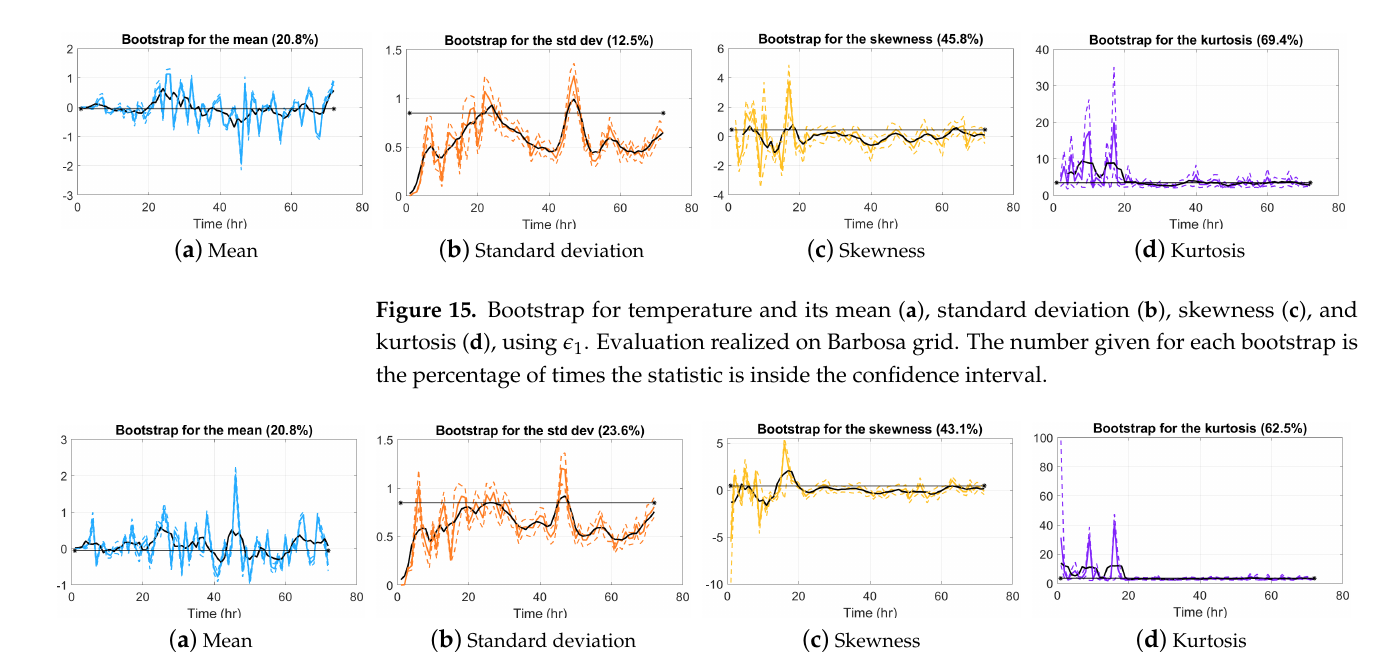
Figure 14. Bootstrap for temperature and its mean ( a ), standard deviation ( b ), skewness ( c ), and kurtosis ( d ), using (cid:101) 1 . Evaluation realized on AMVA grid. The number given for each bootstrap is the percentage of times the statistic was inside the confidence interval.